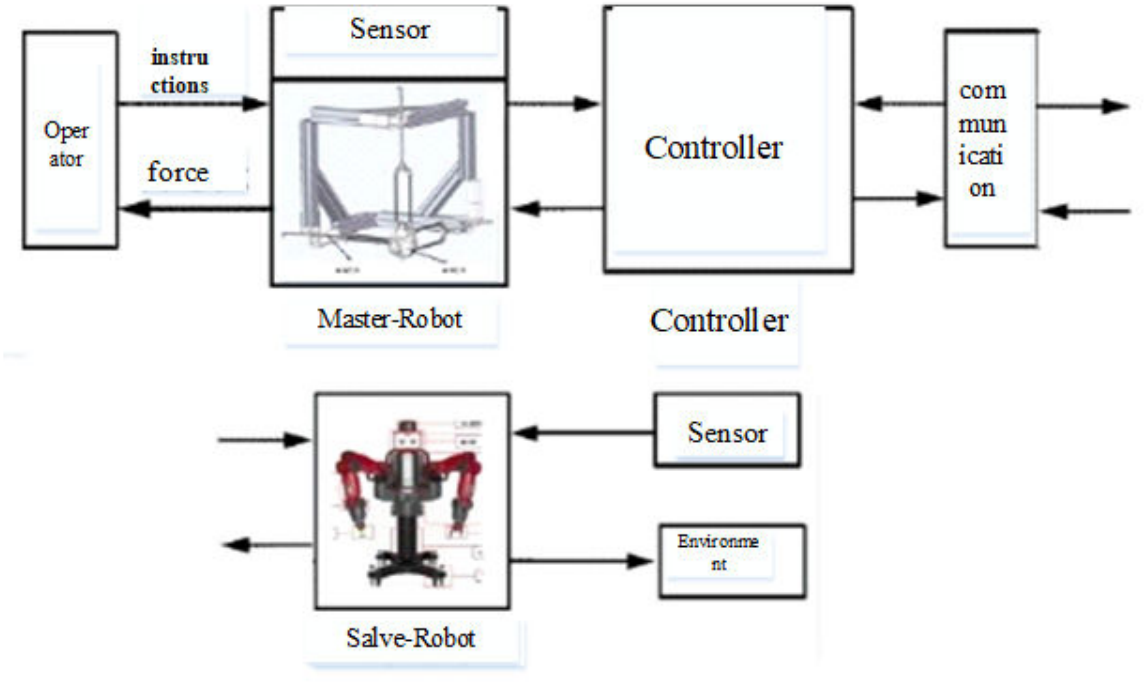
Figure 6. Asymmetric Teleoperation